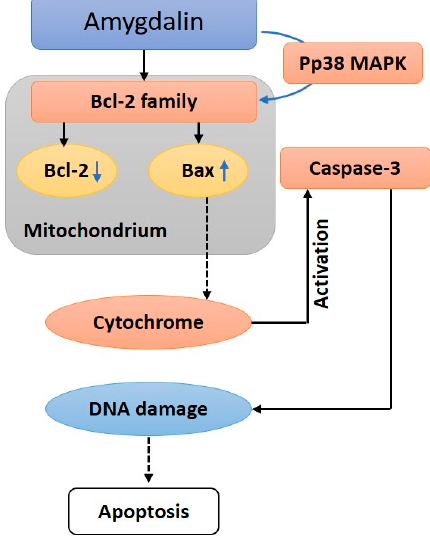
Figure 5. A schematic depicting how amygdalin induces apoptosis; amygdalin activates Pp38, which increases the level of BAX apoptotic proteins and decreases the quantity of Bcl ‐ 2 anti ‐ apop ‐ totic proteins and activates caspase ‐ 3.